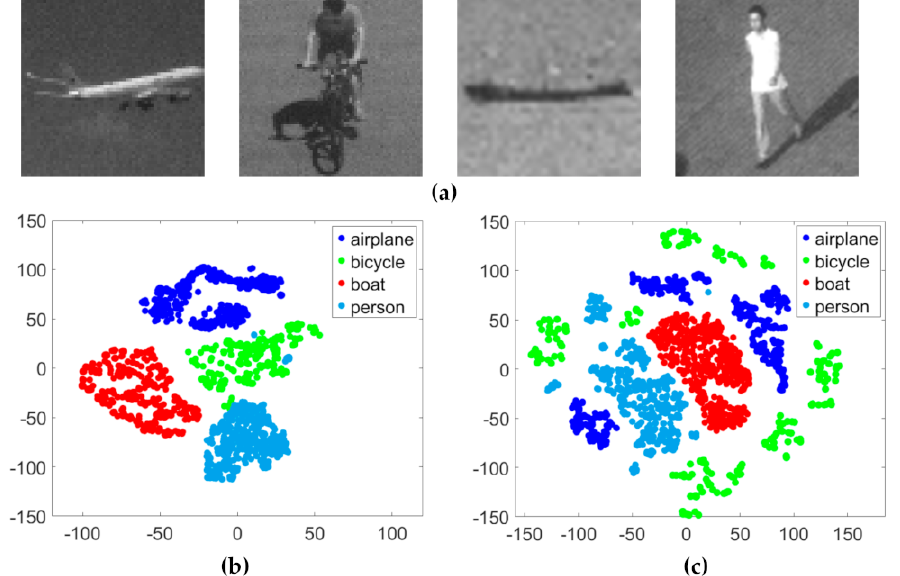
Figure 4. The scatter-plot visualization representations of different objects generated for the HSI and RGB datasets using t-SNE. ( a ) Sample images of the dataset (airplane, bicycle, boat, and person). ( b ) Visualization of the HSI dataset. ( c ) Visualization of the RGB dataset. The x axis and y axis represent the two feature values of the data in two-dimensional space, respectively. There are four kinds of objects, each of which is represented a particular color.